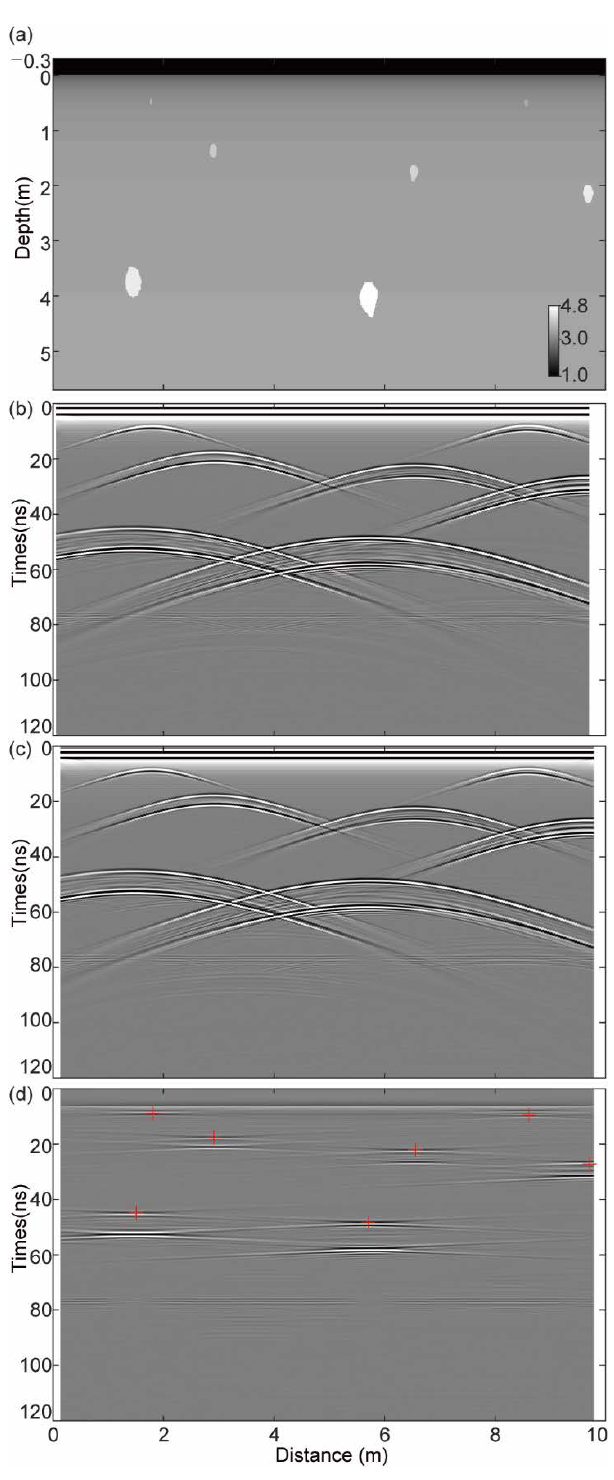
Figure 3. ( a ) The synthetic regolith model; ( b ) forward result with offset of 0.16 m; ( c ) forward result with offset of 0.32 m; ( d ) the local correlation defined in Section 2.2 for the two filtered data. The red-cross indicates the vertex position of the diffractions and the white color indicates the maximum value of local correlation.